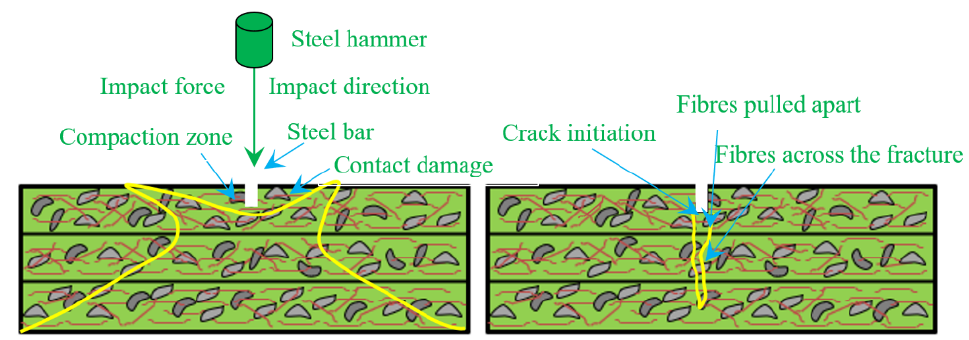
Figure 14. Failure mechanism. Figure 14. Failure